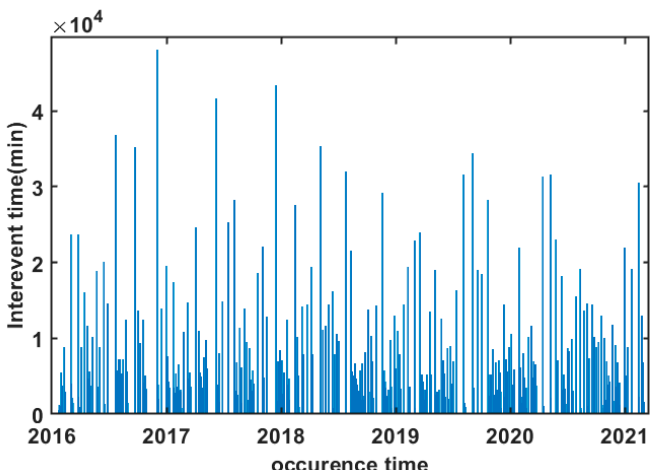
Figure 3. Interevent times between two successive events versus occurrence time of each event for a radius R = 80 km around the epicenter and a magnitude threshold, M th =